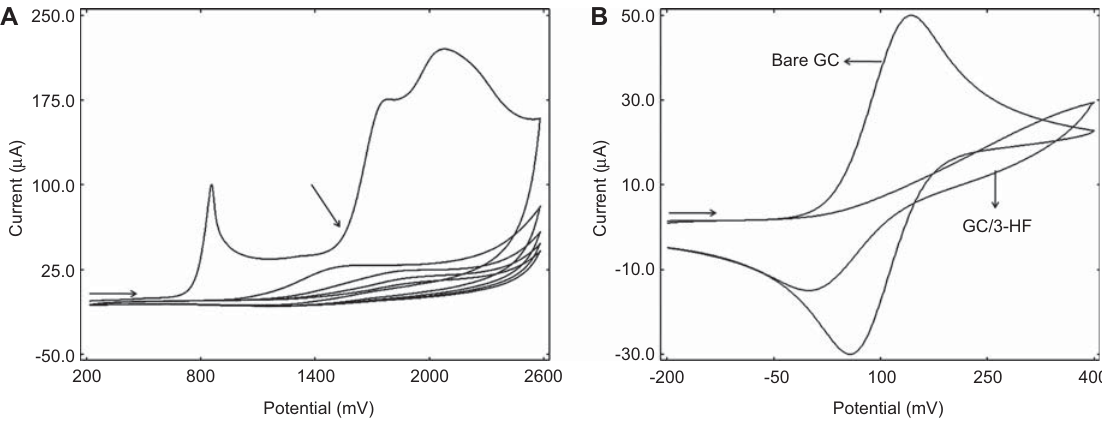
Figure 3 (A) Cyclic voltammogram of 1 m m 3-HF in 0.1 m TBATFB, + 0.2 V and + 2.6 V potential range using 100 mV s -1 with fi ve cycles; (B) surface characterization with ferrocene.